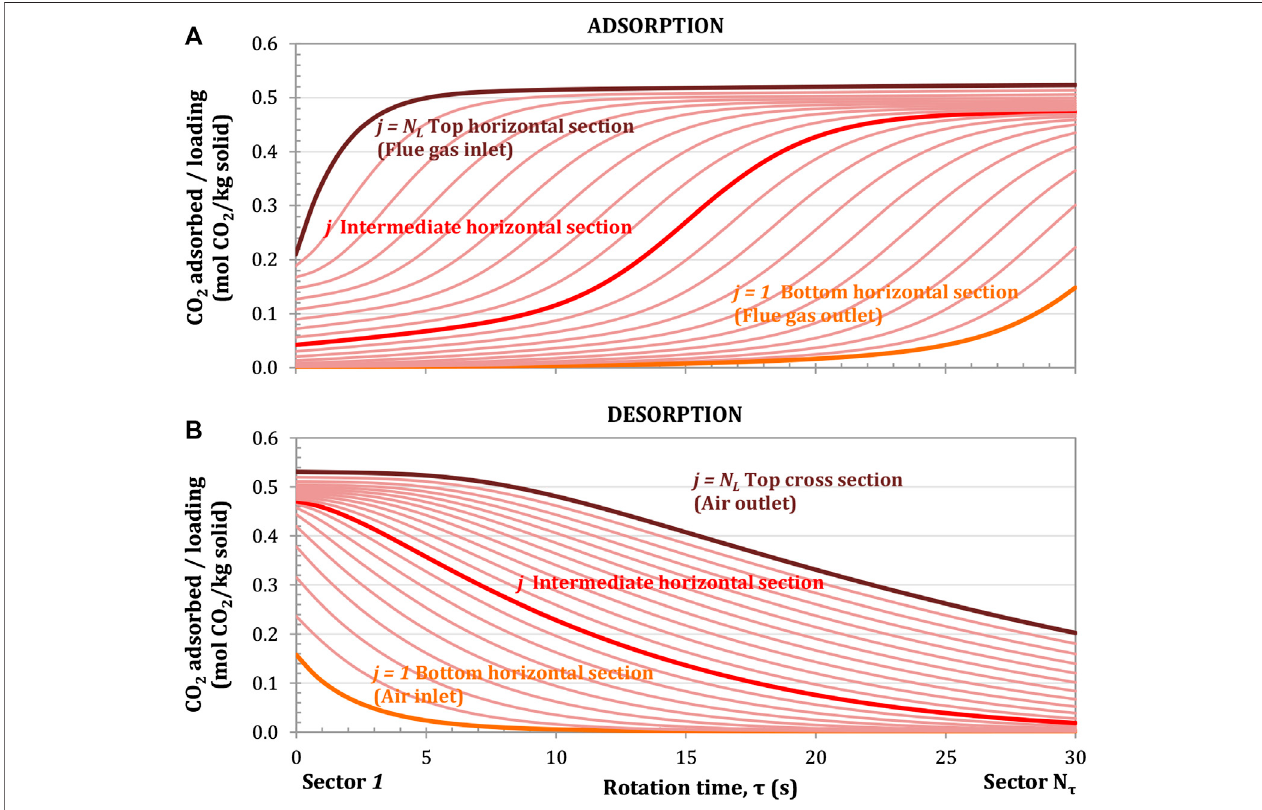
FIGURE 7 | CO 2 adsorption pro fi le for the adsorption (A) and desorption (B) processes at different horizontal sections. Rotation speed of 1 rpm. Con fi guration: parallel S-EGR at 70% recirculation ratio. Adsorbent: Activated Carbon.